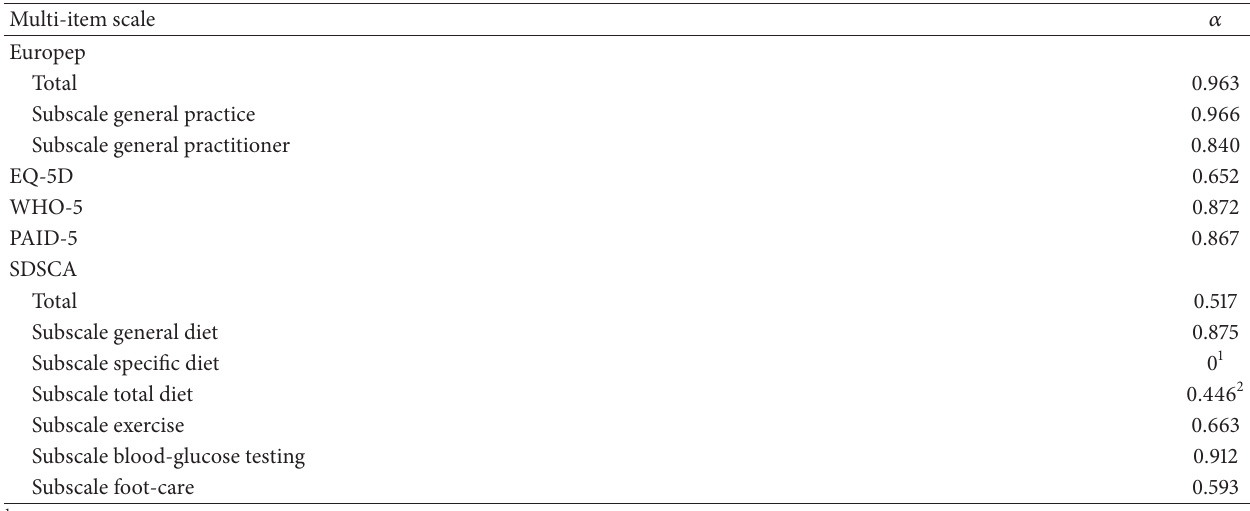
Table 2: Cronbach’s alpha for multi-item